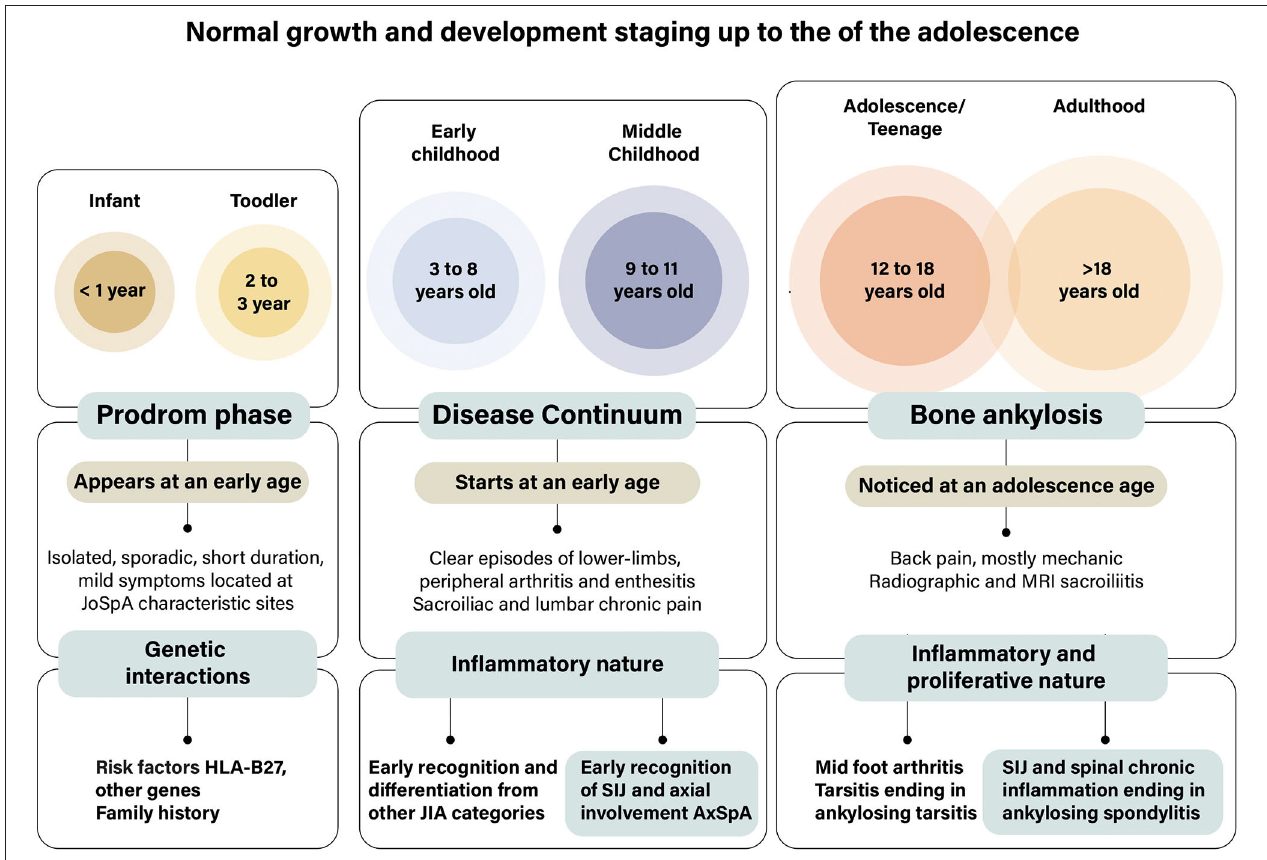
FIGURE 4 | Stages in the development of foot affection in juvenile-onset spondyloarthritis. We proposed three stages to approach the early symptoms of foot affections in patients with JoSpA. The duration of each of the stages is certainly unknown since information is scarce. Few symptoms, such as isolated, sporadic, short duration, episodes of joint pain often considered growing pains, characterize the prodrome stage. Around the age of 8 years starts the inflammatory stage of the disease, which is mostly characterized by arthritis, enthesitis, and axial involvement; this is the disease “continuum” stage, which merged with tarsal ankylosis in the adolescent years or sacroiliac and spinal ankylosis in early adulthood. This is a clinical picture needing differentiation from other diseases, particularly from subgroups of juvenile idiopathic arthritis. At the same time, the relation between children and adult diseases should be established via de sacroiliac and spinal demonstration in children. These events take place when there are several changes in growth and development in childhood and adolescence.